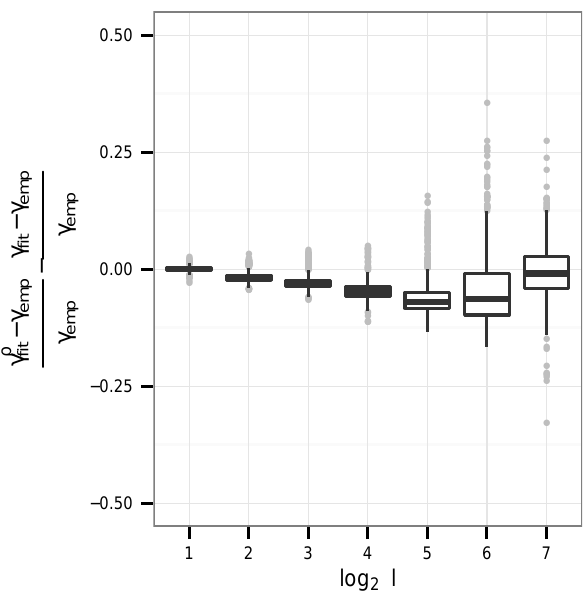
Fig. 15. The difference between the relative error of the distribution without correlation, and that with correlation propagated from the largest scale. The inclusion of correlations leads to small, but consistent, improvements (i.e. negative values). It is immediately clear that the coarsest scale is not well captured by the functions, evidenced by the large relative error.